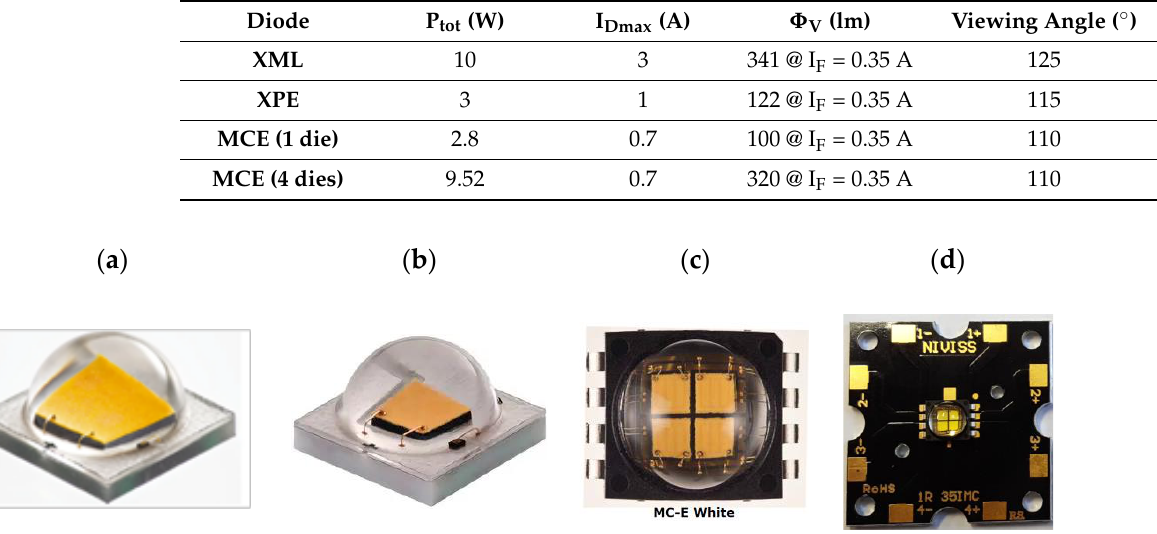
Figure 3. View of the cases of the investigated diodes XML ( a ), XPE ( b ), MCE ( c ), and the MCPCB used for MCE diode ( d ). Table 2. Values of selected parameters of tested power LEDs [22,27,28].